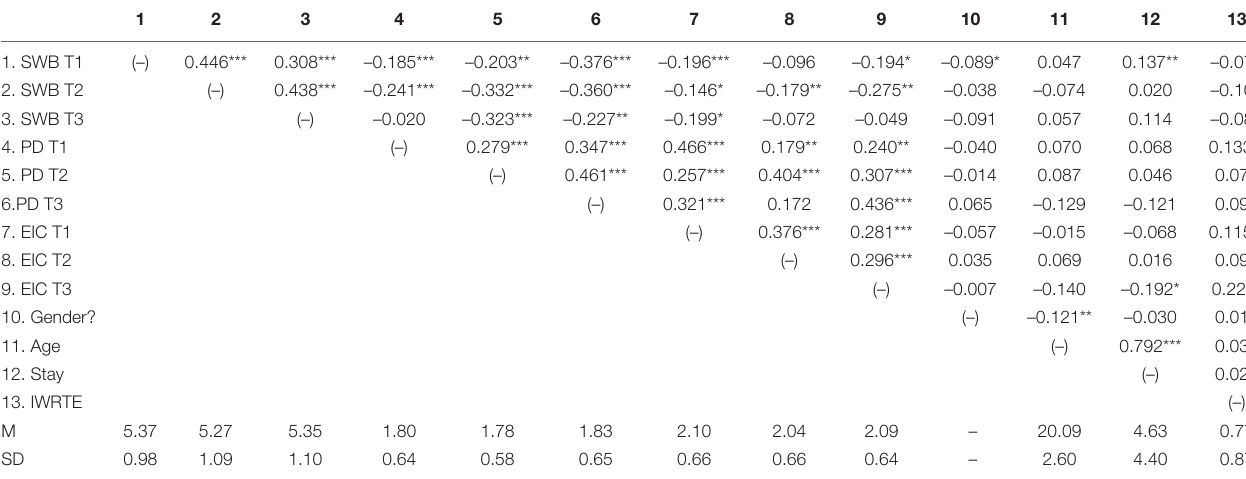
TABLE 1 | Descriptives of the measures and intercorrelations among the observed variables.